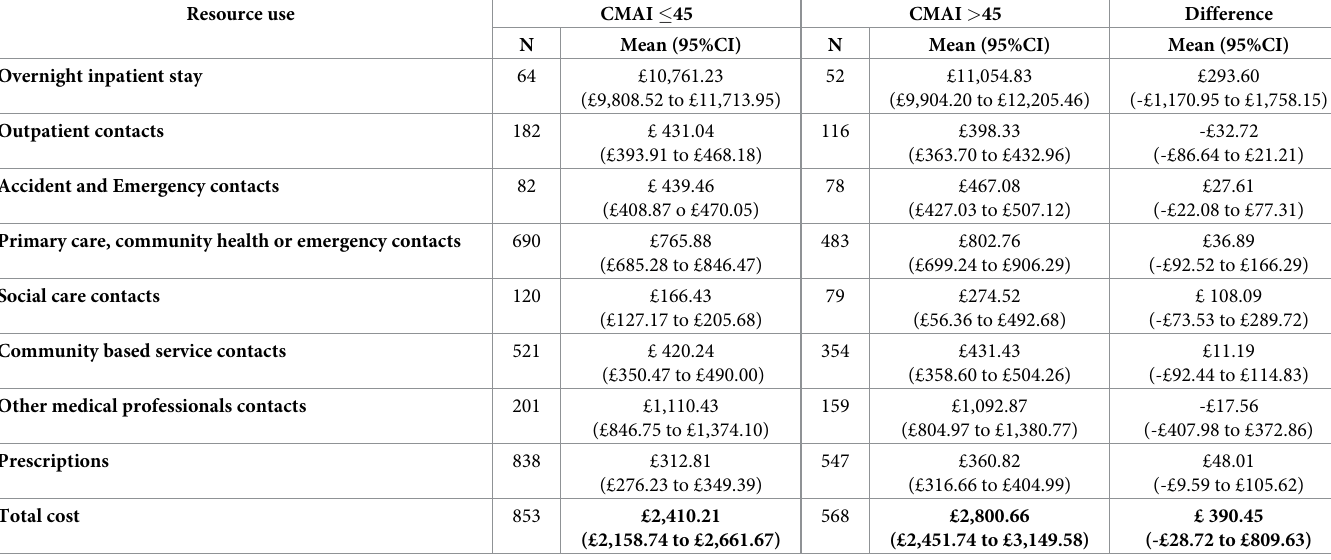
Table 2. Annual mean costs per resident by CMAI scores (£, 2014/15 UK).